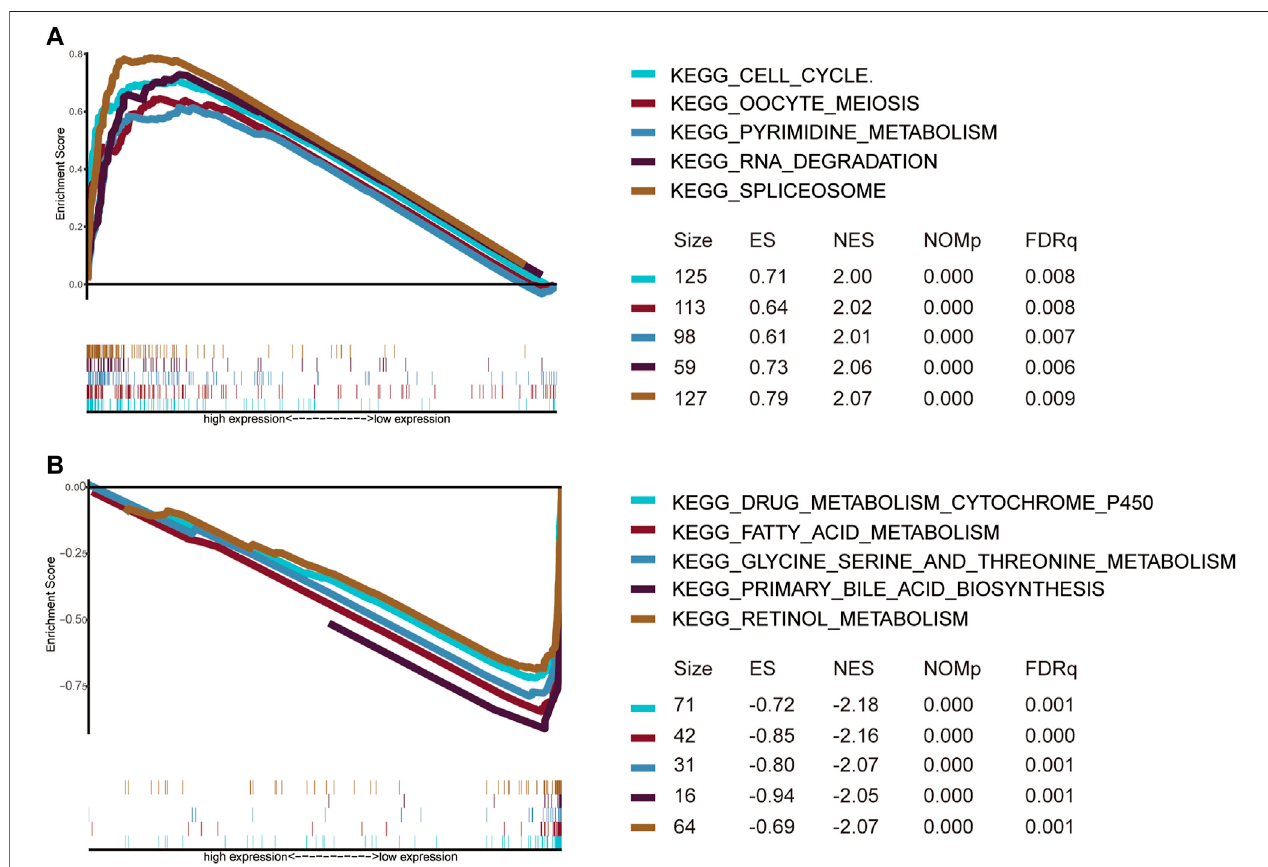
FIGURE 11 | Gene set enrichment analysis of pathways for high (A) and low (B) EMT risk groups.